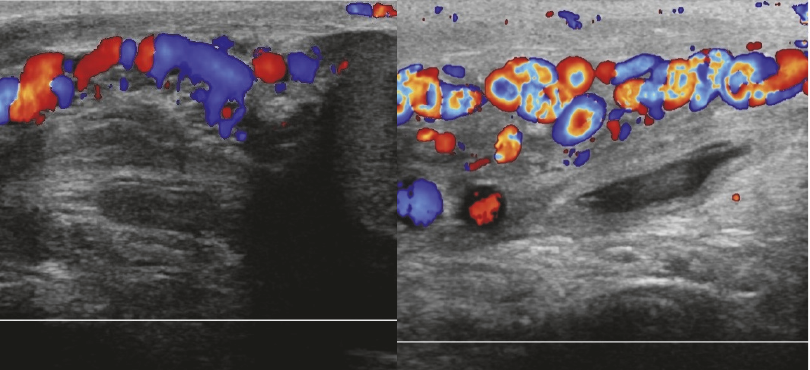
Figure 5: Doppler ultrasonography: dilated paratesticular veins, compatible with the presence of the varicocele. Presence of reflux during Valsalva